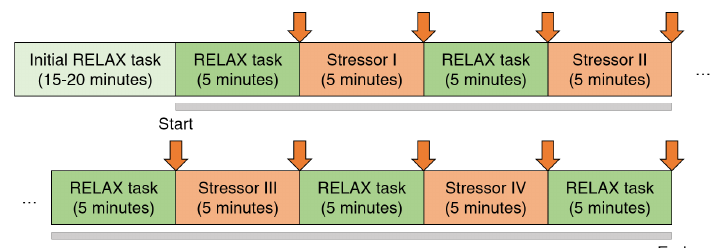
Figure 1. An experiment process. There are two stages for the whole experiment: an initial relaxation stage (colored with light green), and a regular experiment stage (indicated by gray bold lines). The regular experiment stage can be segmented into 5 min of relax tasks (colored with dark green) and stress tasks (colored with dark orange). From the start to end of the regular experiment stage, subjects’ physiological signals were captured by a wearable device. At the end of each short a relax or a stress task, a mental stress level assessment was carried (indicated with an orange